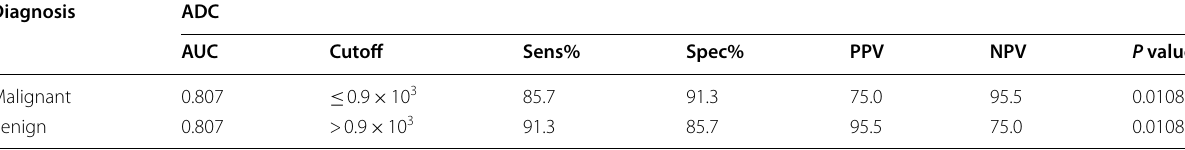
AUC area under curve, Sens sensitivity, Spec specificity, PPV positive predictive value, NPV negative predictive value * P 0.05 is considered significant